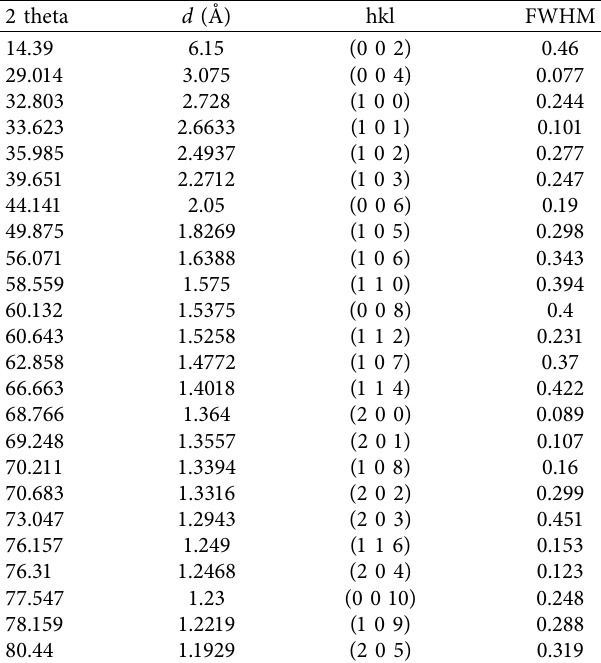
2 /GO. 2 /GO nanocomposite.